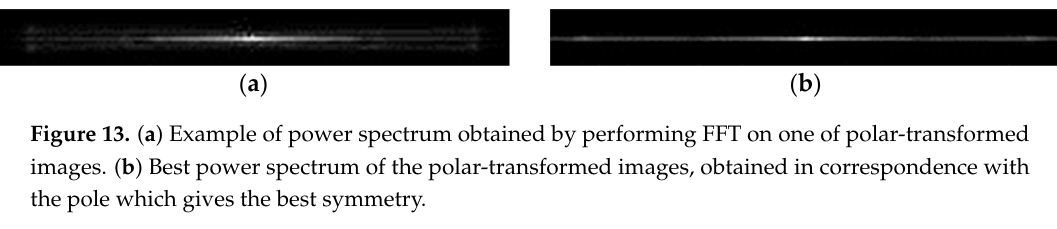
Figure 13. ( a ) Example of power spectrum obtained by performing FFT on one of polar-transformed images. ( b ) Best power spectrum of the polar-transformed images, obtained in correspondence with the pole which gives the best symmetry.